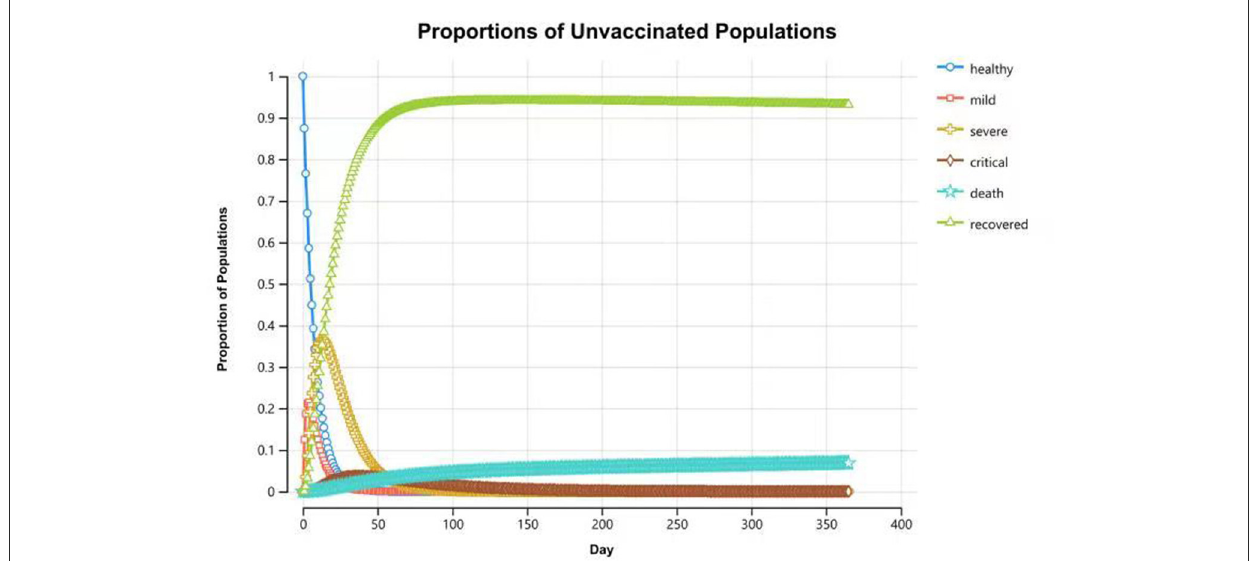
FIGURE5 Proportions of populations by health states in the “ineffectively vaccinated” arm at the end of 1-year time horizon.